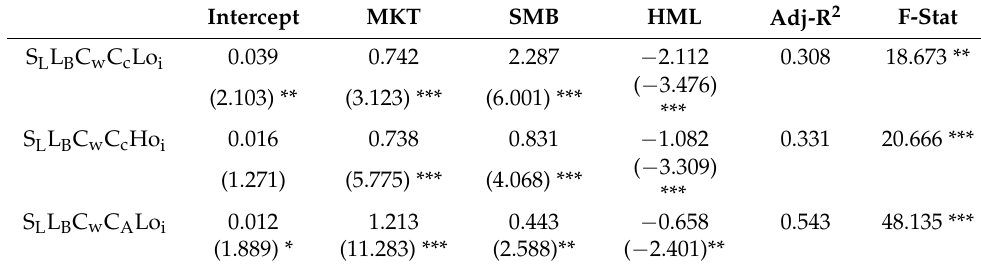
Table 6. Fama–French Three-Factor